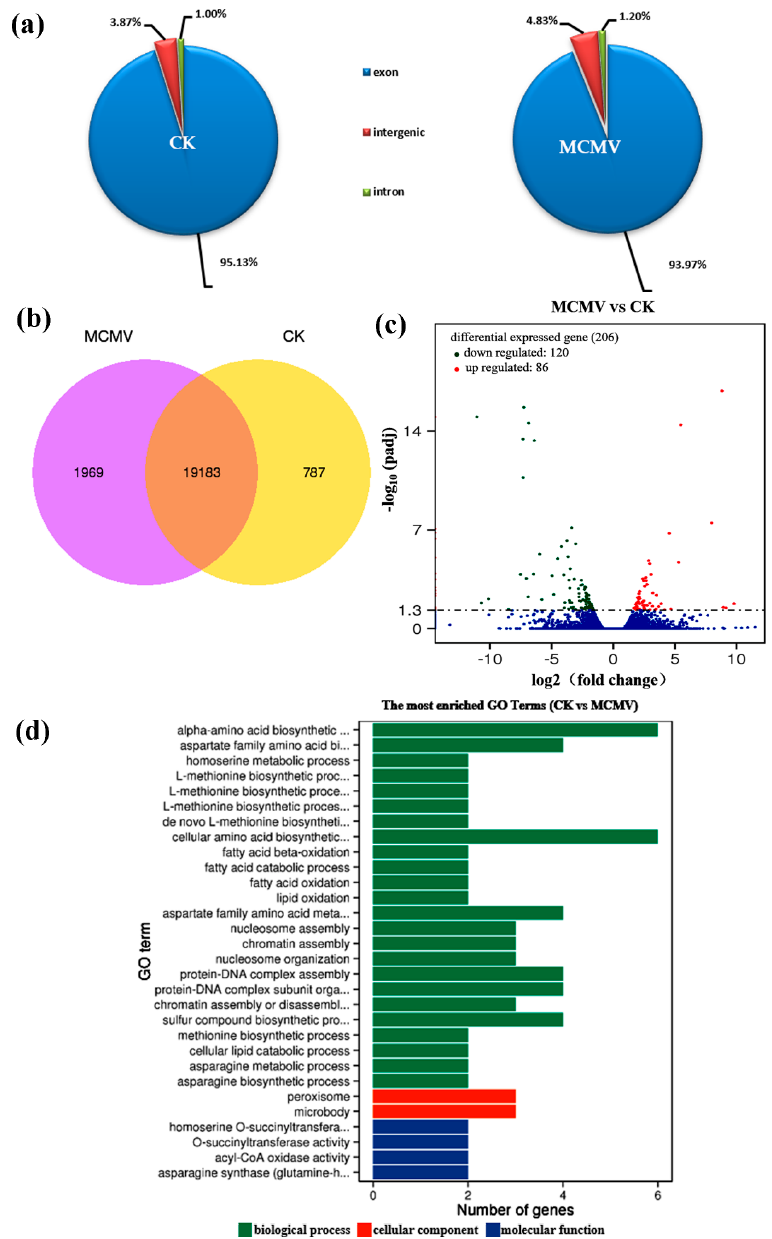
Figure 2. Overview of MCMV-induced responses in the maize transcriptome. ( a ) Graphical mapping summary with distribution of mapped reads across the regions of the reference genome. ( b ) Venn diagram illustrating the distribution of statistically significant changes in gene expression and their overlap among experimental groups. ( c ) Scatterplot analysis of di ff erential gene expression in maize 7 dpi after MCMV infection compared with CK, a red dot stands for one up-regulated gene, a green dot for one down-regulated gene and a blue dot for one non-significantly changed gene. ( d ) Gene Ontology (GO) categories of enriched transcripts in maize leaves in response to MCMV infection determined using GO-seq. Data were taken from three biological replicates. CK: mock-inoculated maize; MCMV: MCMV-inoculated